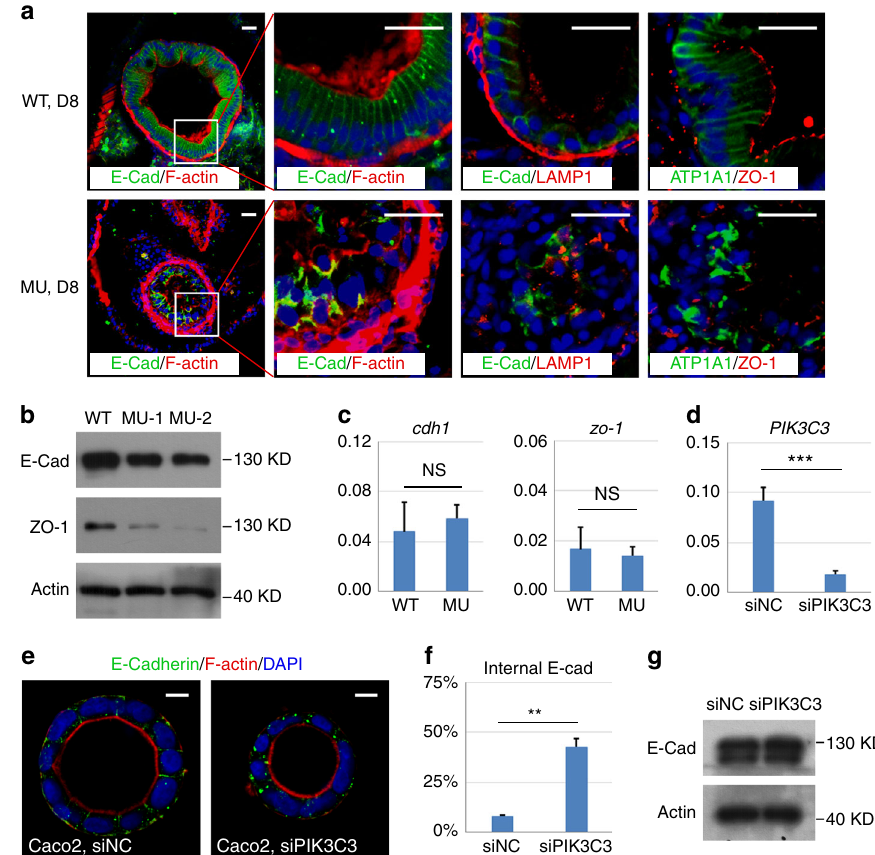
Fig. 6 PIK3C3 de fi ciency induces polarity defects in IECs. a Immuno fl uorescence staining of gut cross sections at 8 dpf. In WT embryos, columnar IECs are arranged into a sheet and E-Cadherin are laterally distributed. IECs become disorganized and E-Cadherin is endocytosed and forms intracellular aggregates in the mutants. LAMP1 is a lysosome marker and it does not co-localize with E-Cadherin aggregates. Other polarity-related proteins including Na,K-ATPase alpha 1 subunit (ATP1A1) and tight junction protein ZO-1 also lose their polarized distributions in the mutant guts. Scale bar, 20 µ m. b Western blot analysis for the expression levels of E-Cadherin and ZO-1 in the dissected digestive tracts from 8 dpf embryos. Beta actin is the loading control. c qRT-PCR analysis of cdh1 and zo-1 . Assays are performed as described in Fig. 3f. d Knockdown ef fi ciency of PIK3C3 by siRNA in Caco2 cells as determined by qRT-PCR. ACTB is the internal control and data represent mean ± SD from three biological repeats (*** p < 0.001 by unpaired two-tailed Student ’ s t -test). e